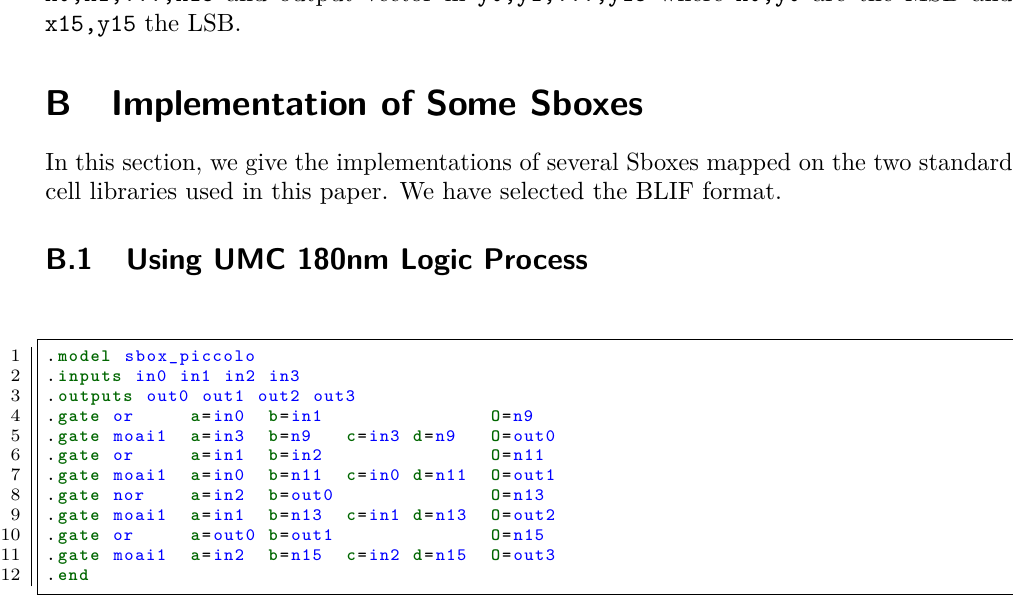
Figure 4: Area-optimized hardware implementation of PICCOLO Sbox using 13.00 GE with the standard cell library of the UMC 180nm logic